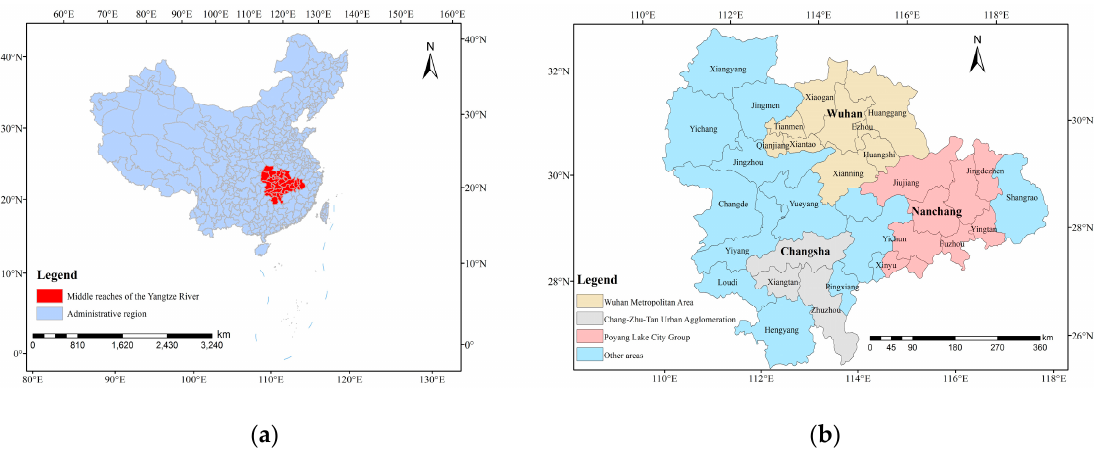
Figure 1. Location of the study area: ( a ) location of the study area in China; ( b ) the composition of the study area.